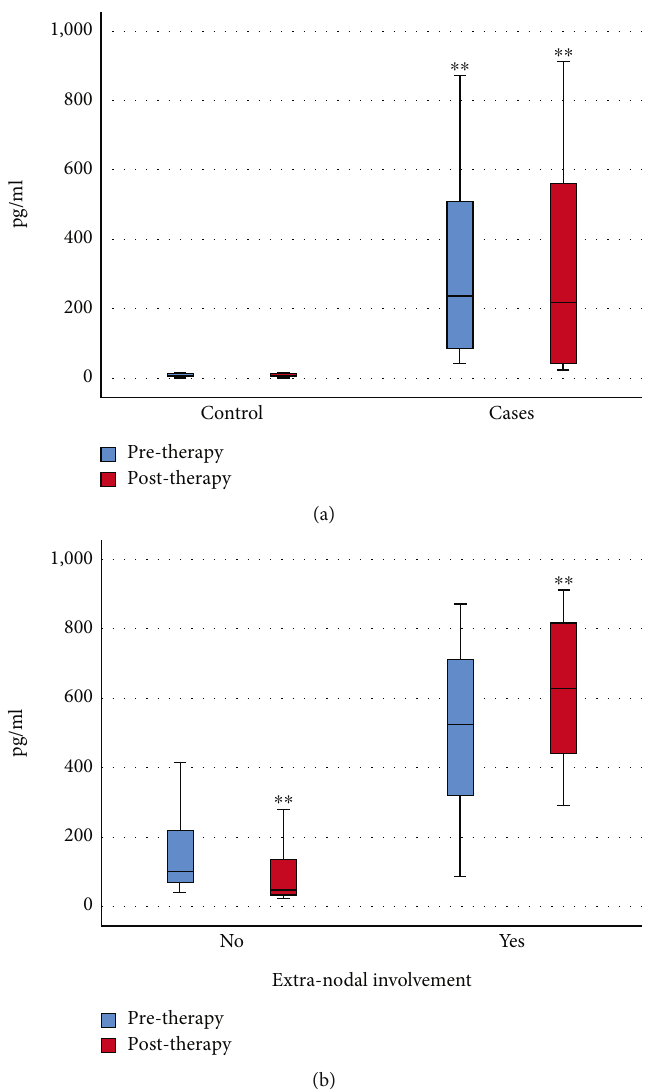
Figure 2: IL-19 concentrations in healthy volunteers and lymphoma patients. (a) Pretherapy and posttherapy IL-19 levels in 78 lymphoma patients and 50 healthy volunteers. (b) Pretherapy and posttherapy IL-19 levels in patients without and with extranodal involvement. ∗∗ identi fi es high signi fi cant di ff erences at P < 0 : 001